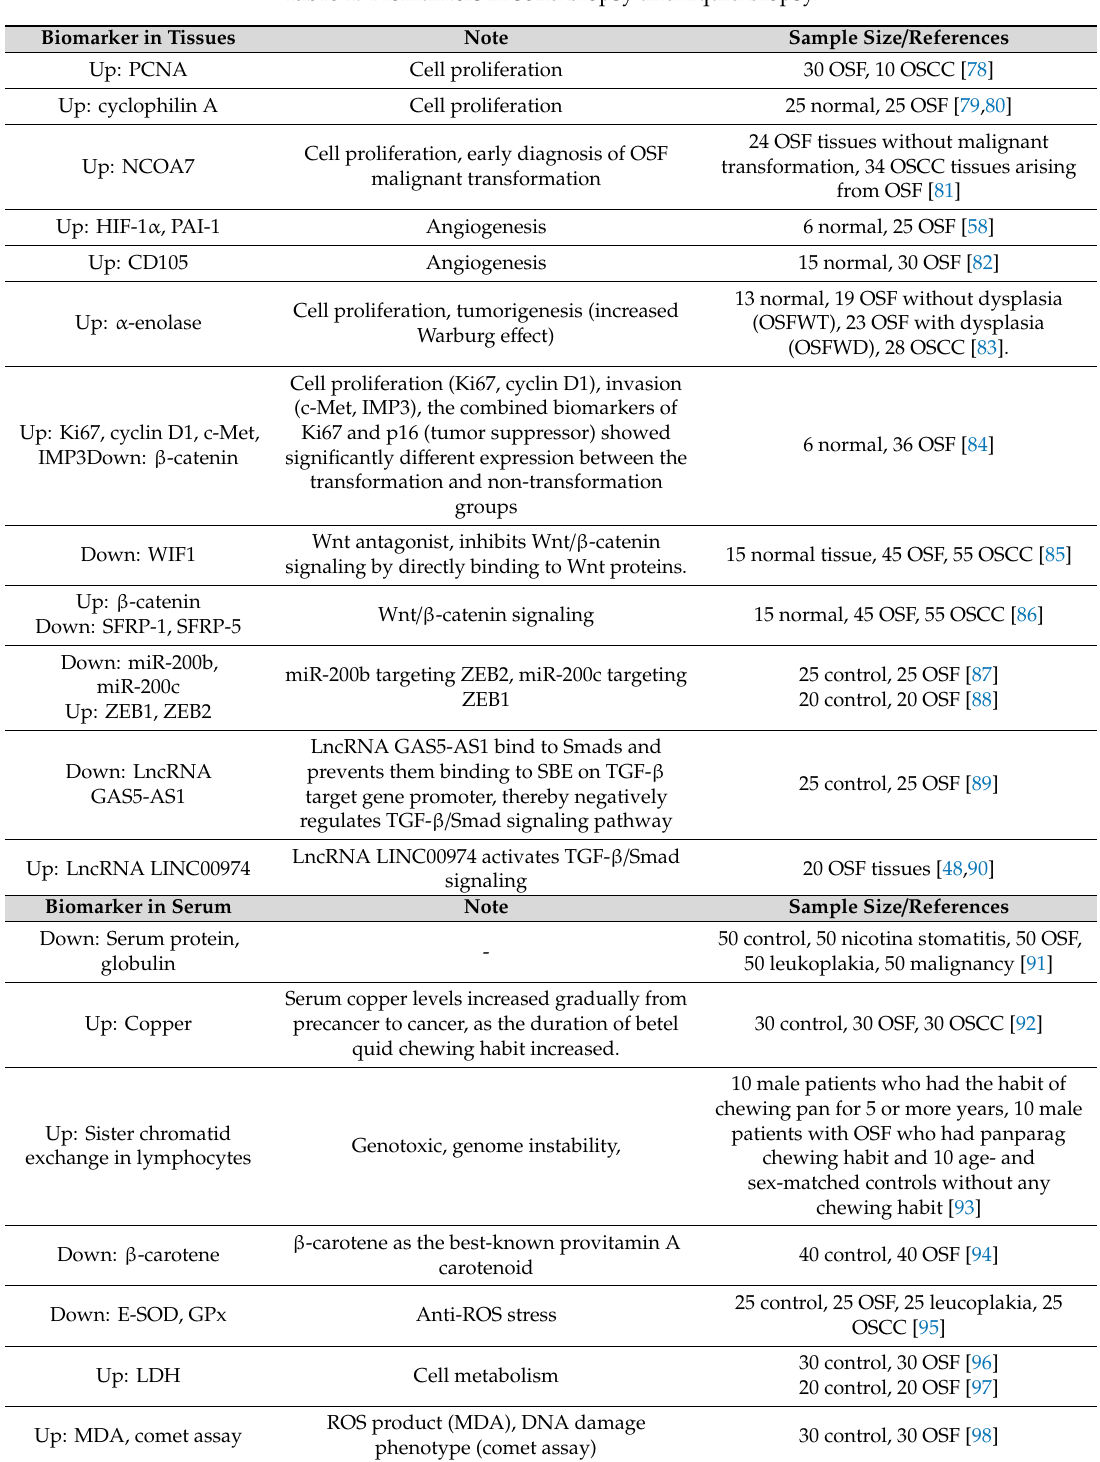
Table 1. Biomarkers in solid biopsy and liquid